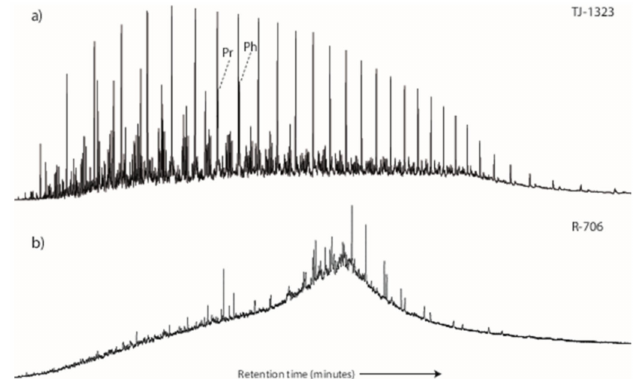
Figure 4. Total ion chromatogram of the saturated fraction of TJ-1323 ( a ) and R-706 ( b ) oils.